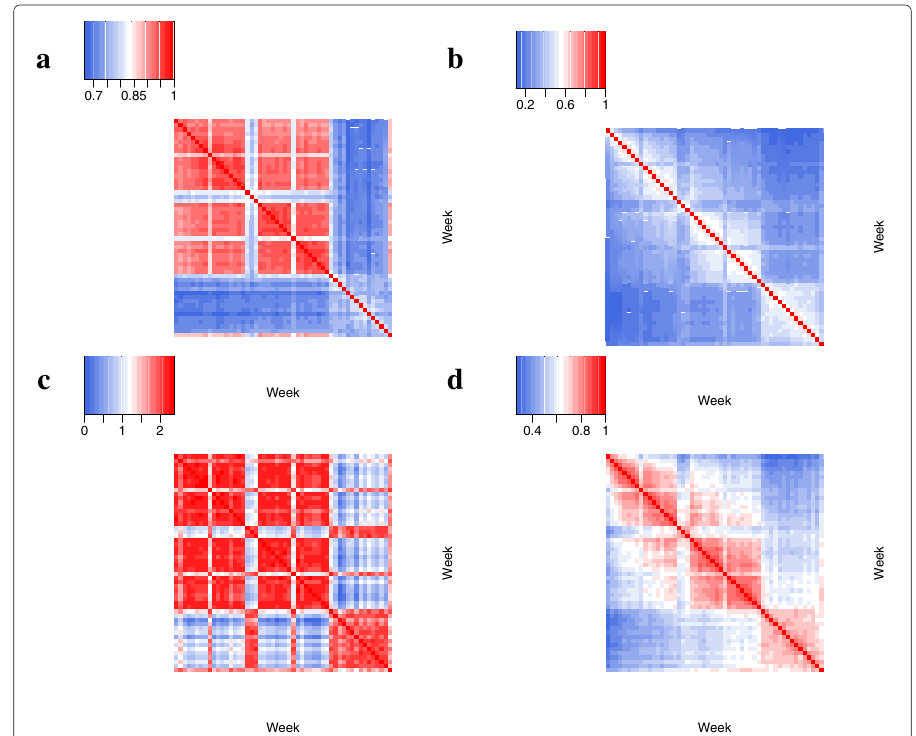
Fig. 5 Pairwise network similarities with respect to four measures: a node overlap (NO); b edge overlap (EO); c graphlet correlation distance (GCD); d correlation between degrees (DEGC) over all nodes. Other global (GDDA and RGFD) and local network properties (i.e., the remaining centrality measures) show similar trends. Each row/column of a similarity matrix corresponds to the network snapshot of a given week. Values on the diagonals are always 1, because each network snapshot is identical to itself. In each panel, the higher the matrix value, the higher the snapshot similarity. Please note that the different panels do not necessarily use the same color scheme. In each panel, the week number increase from left to right, and from top to bottom